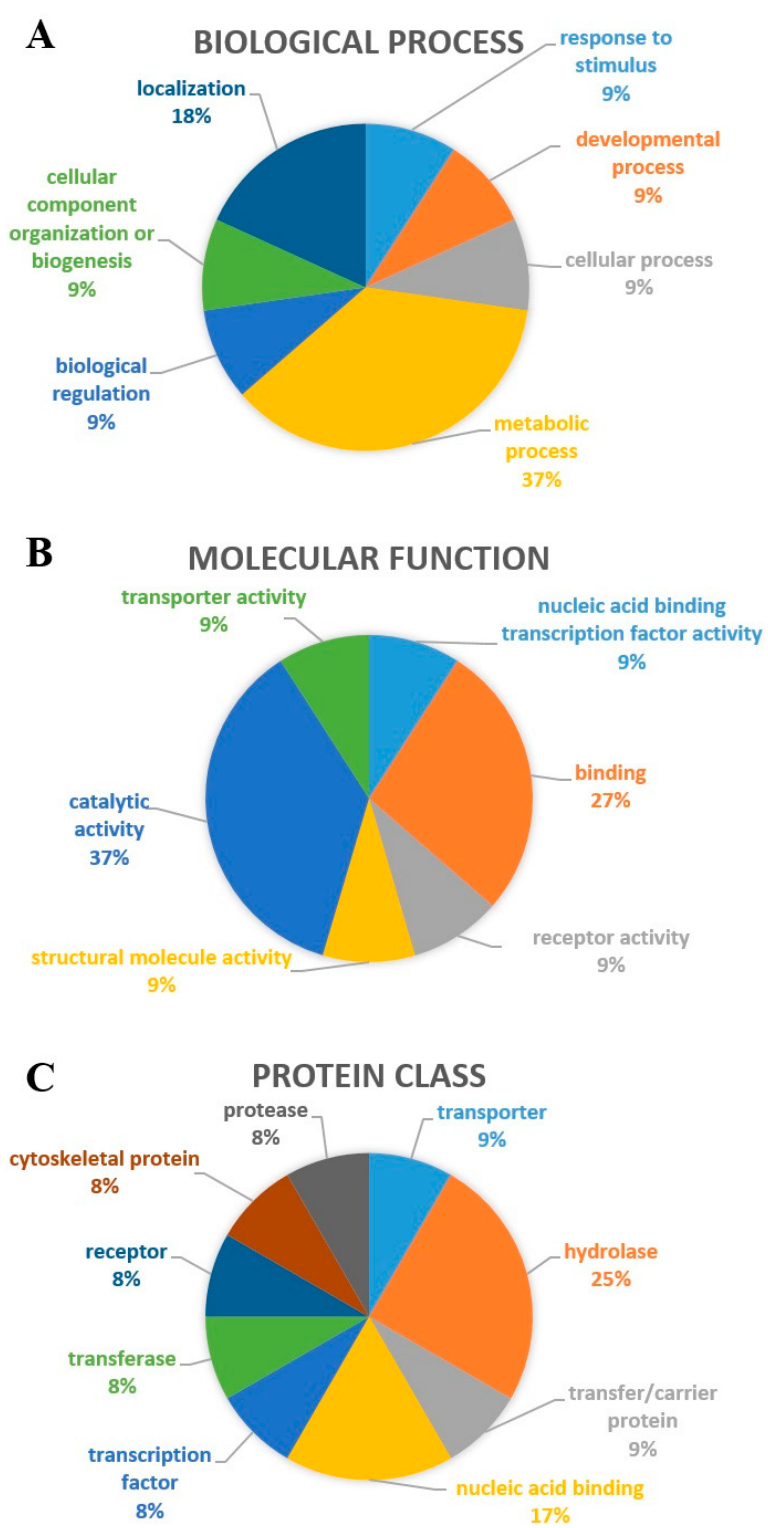
Figure 3. Schematic profile indicating the proportion (%) of the proteins of interest in each category: biological process ( A ); molecular function ( B ); and protein class ( C ).